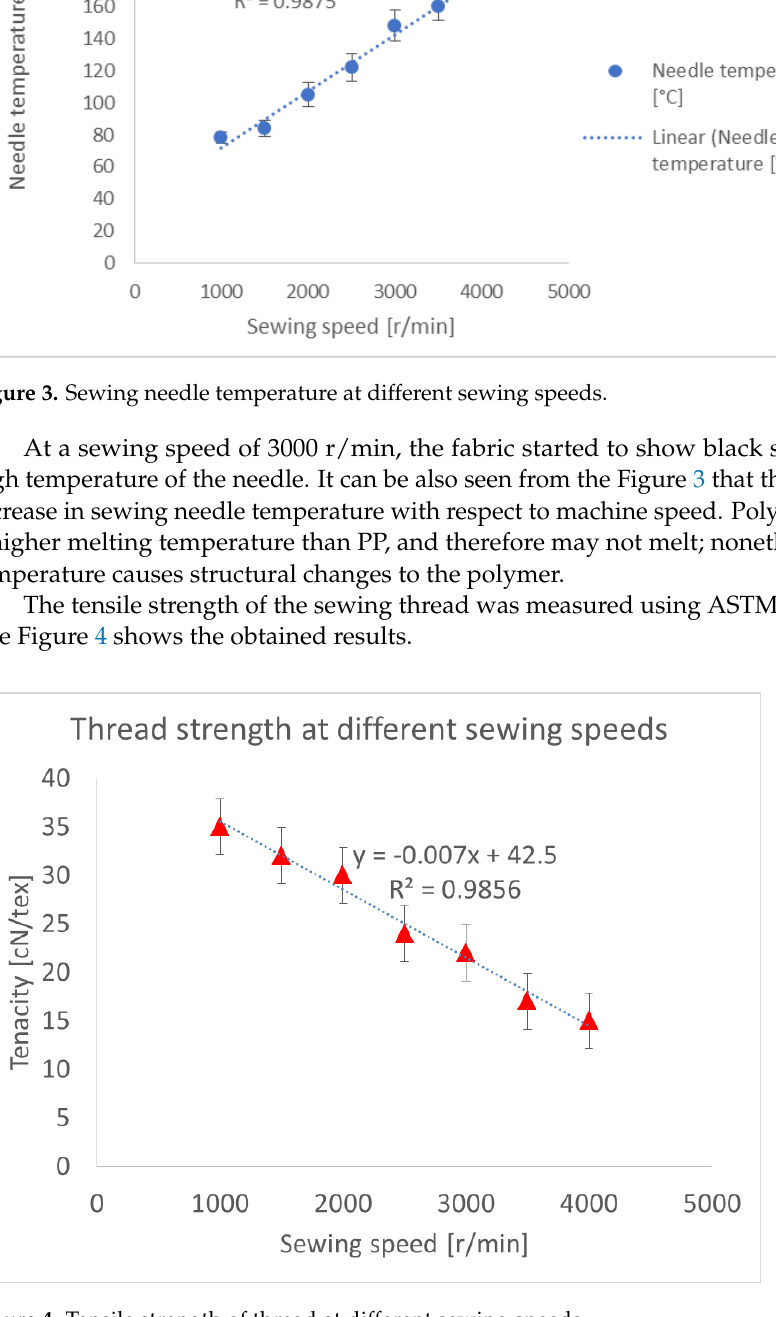
Figure 4. Tensile strength of thread at different sewing speeds.